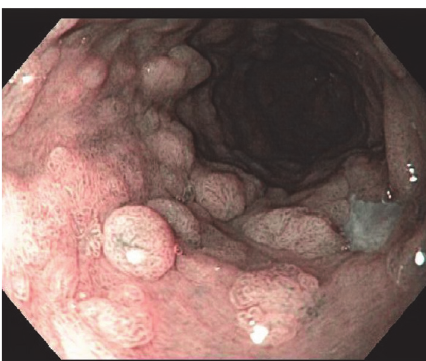
Figure 3: Patient 1 (white light endoscopy). Esophagus with squa- mous-appearing mucosa after RFA.